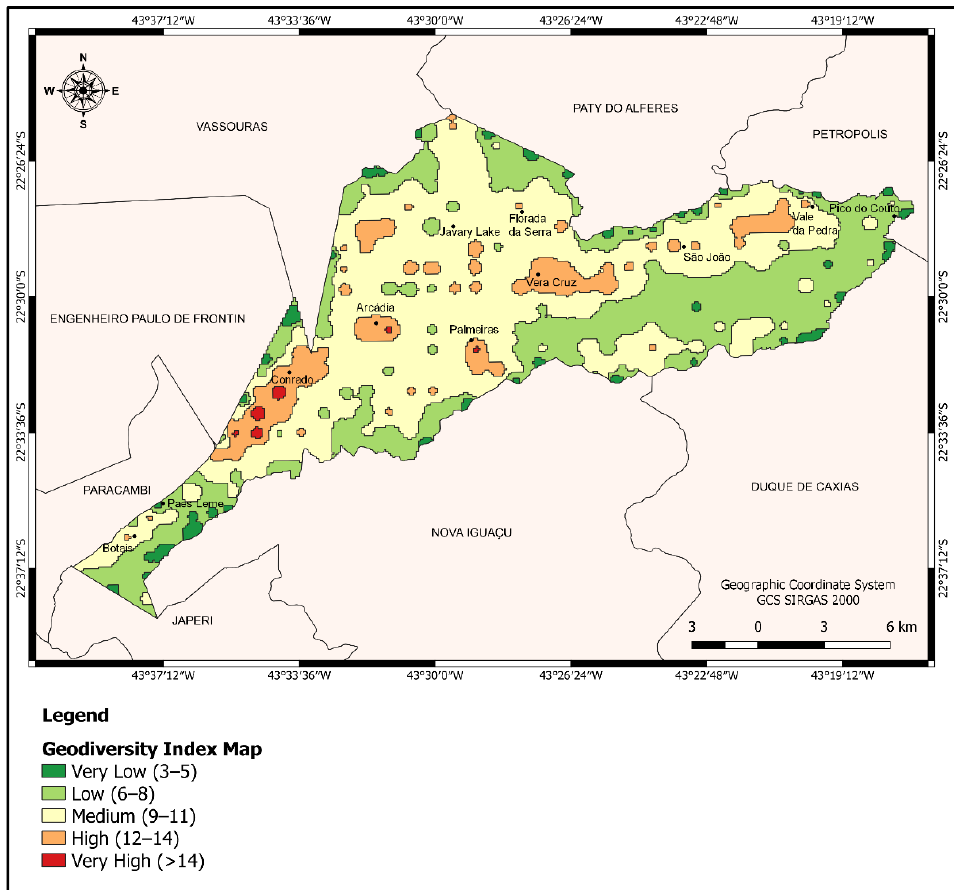
Figure 6. Geodiversity index map of Miguel Pereira municipality, Rio de Janeiro State, Brazil, produced by Gonçalves et al. [23] using the multiparts technique and MOV (Maximum Obtained Value)